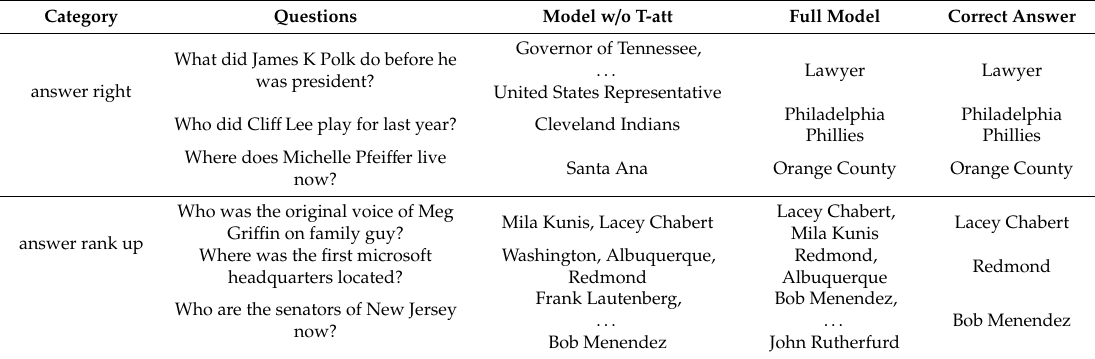
Table 3. Predicted answers of the full model and model w / o the temporal attention module. Where T-att is the temporal attention